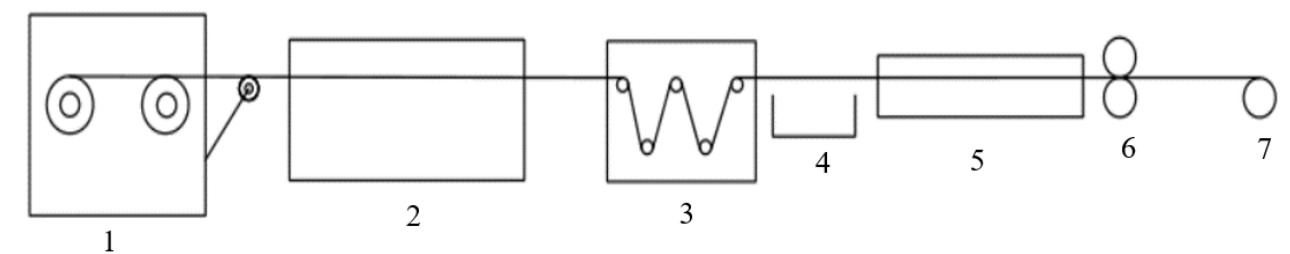
Figure 1. Production and preparation flow chart of CNT/CCF/PEKK prepreg tapes. 1: yarn frame;